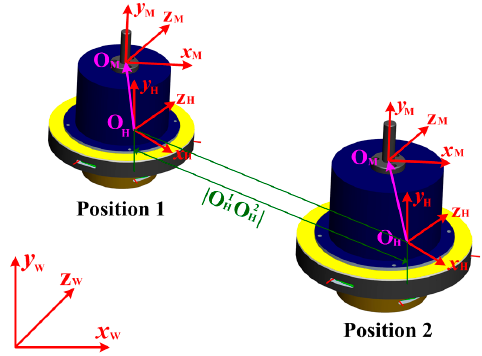
Figure 4. Coordinate system transformation.